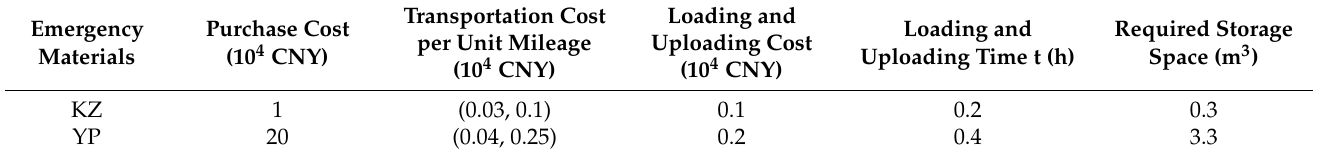
Table 5. Attribute parameters of per unit of emergency materials.